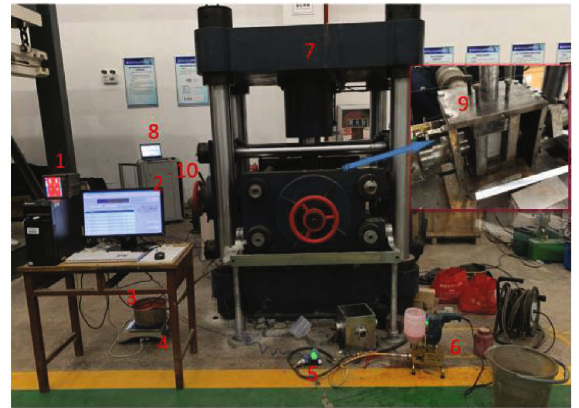
Figure 1: Three dimensional stress grouting